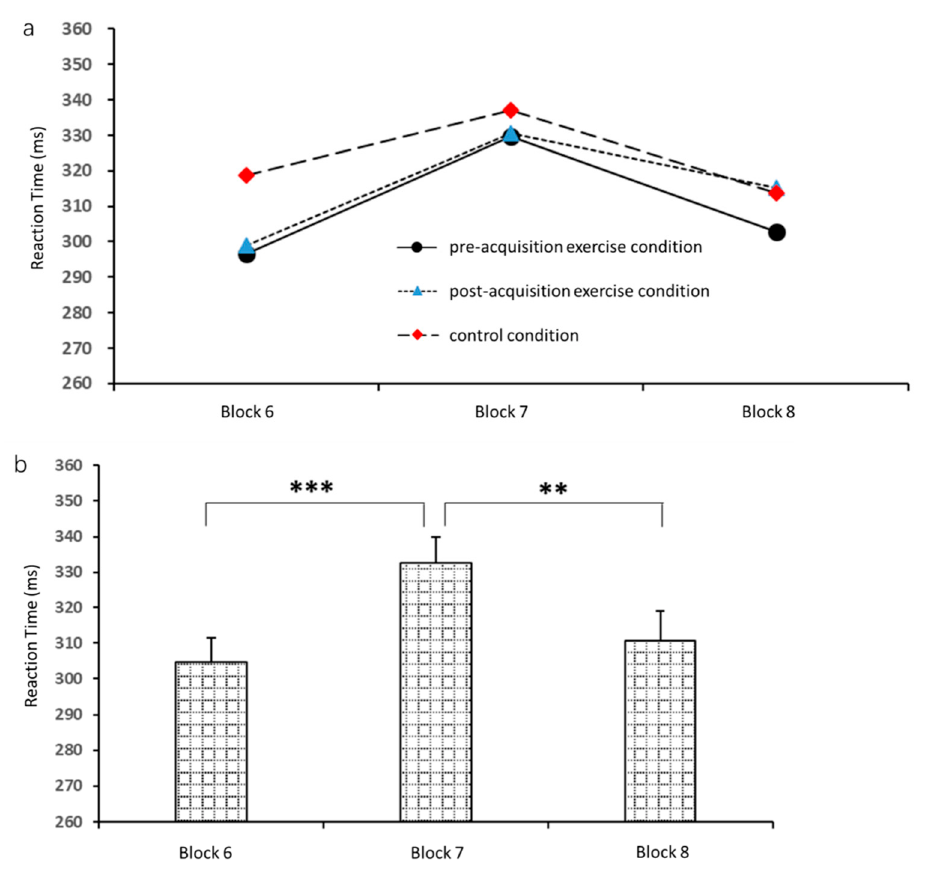
Figure 8. Mean reaction times in the 24-h sequence test by block and by exercise condition. ( a ) Comparison of reaction times among blocks 6, 7, and 8. ( b ) Comparison of reaction times among pre-acquisition exercise, post-acquisition exercise, and control conditions. ** p < 0.01, *** p < 0.001.